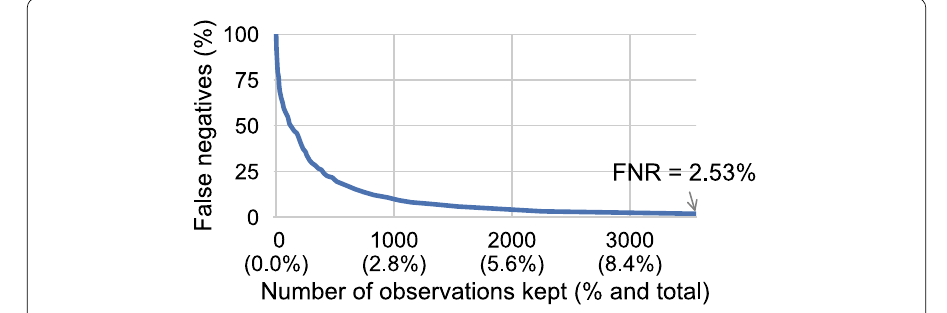
(where observations near at least three licensed CSPs are kept) is